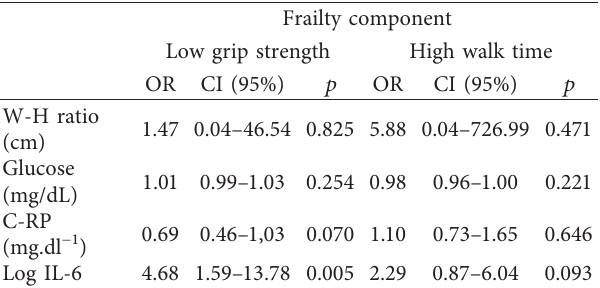
Table 3: Univariate binary logistic regression analyses in a whole- group approach ( n �